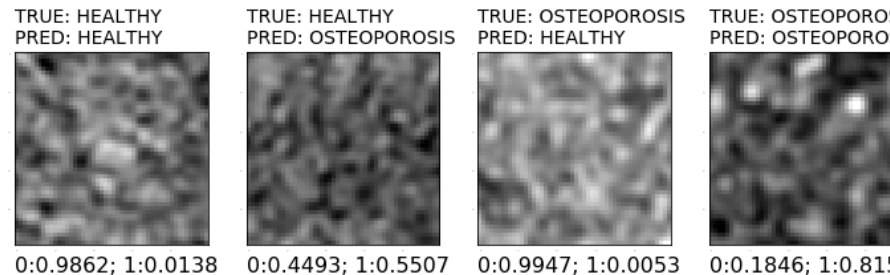
Figure 8. Process flow during the prediction of a class of new images.